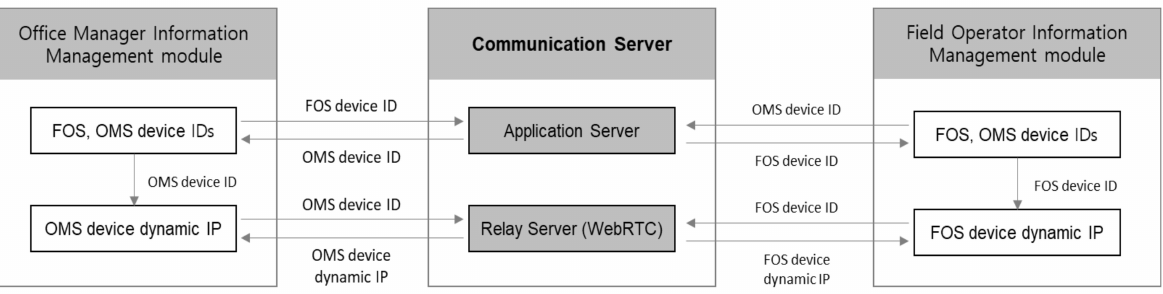
Figure 3. Virtual Object Manipulation: ( a ) Right-hand Model; ( b ) Grab and move gesture to move a virtual object; ( c ) Put down gesture. (Source: Microsoft Hand tracking MRTK2 [22]).